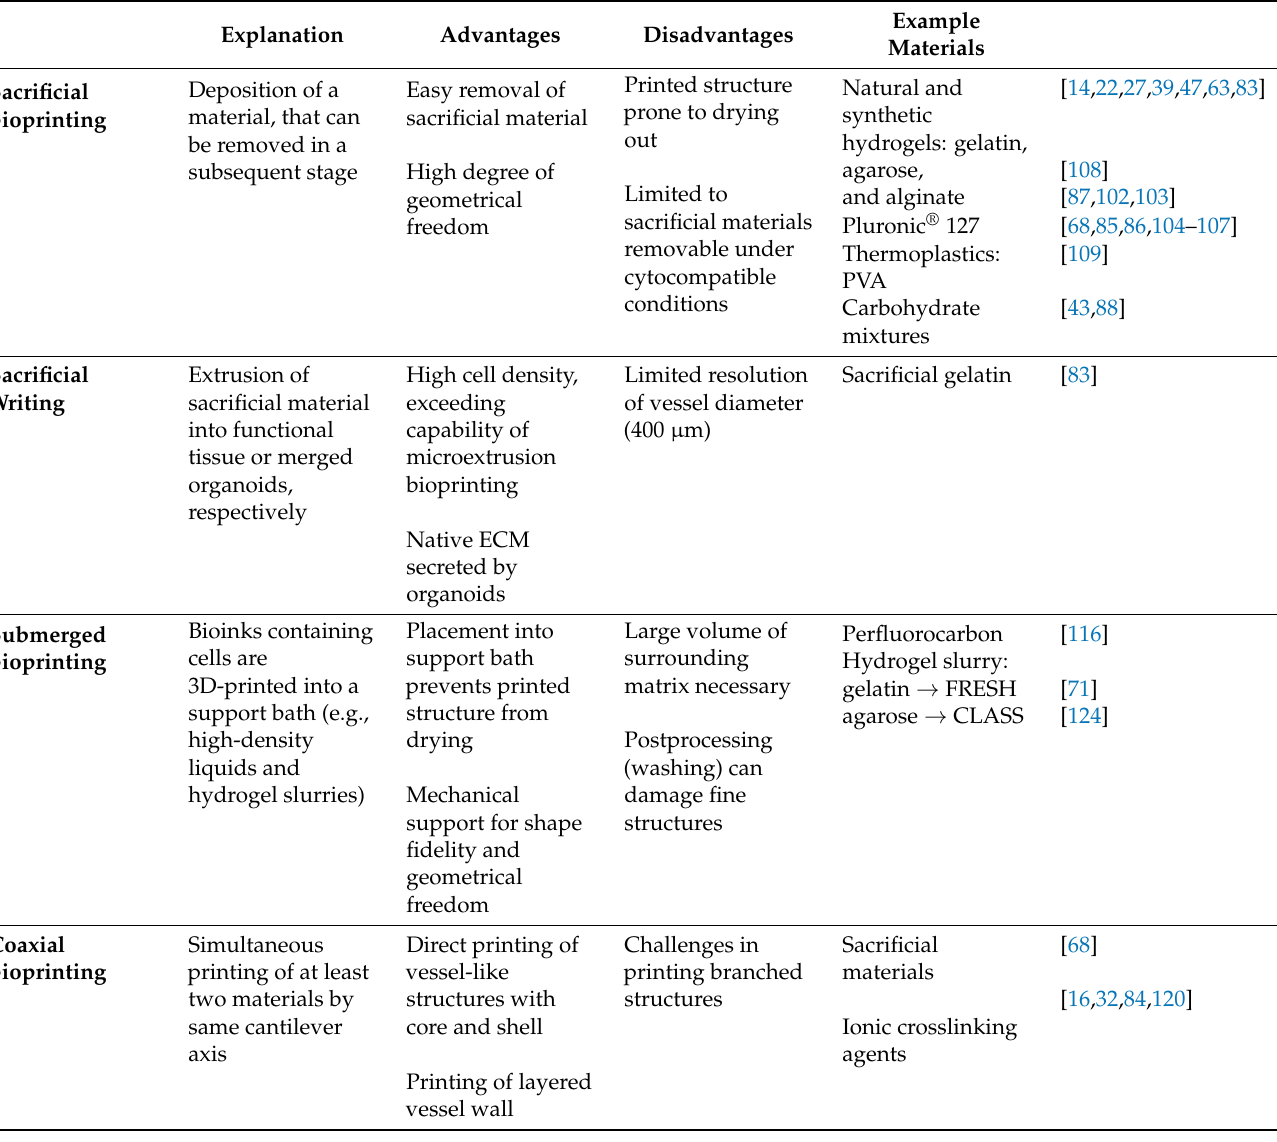
Table 2. Overview: Bioprinting strategies to fabricate